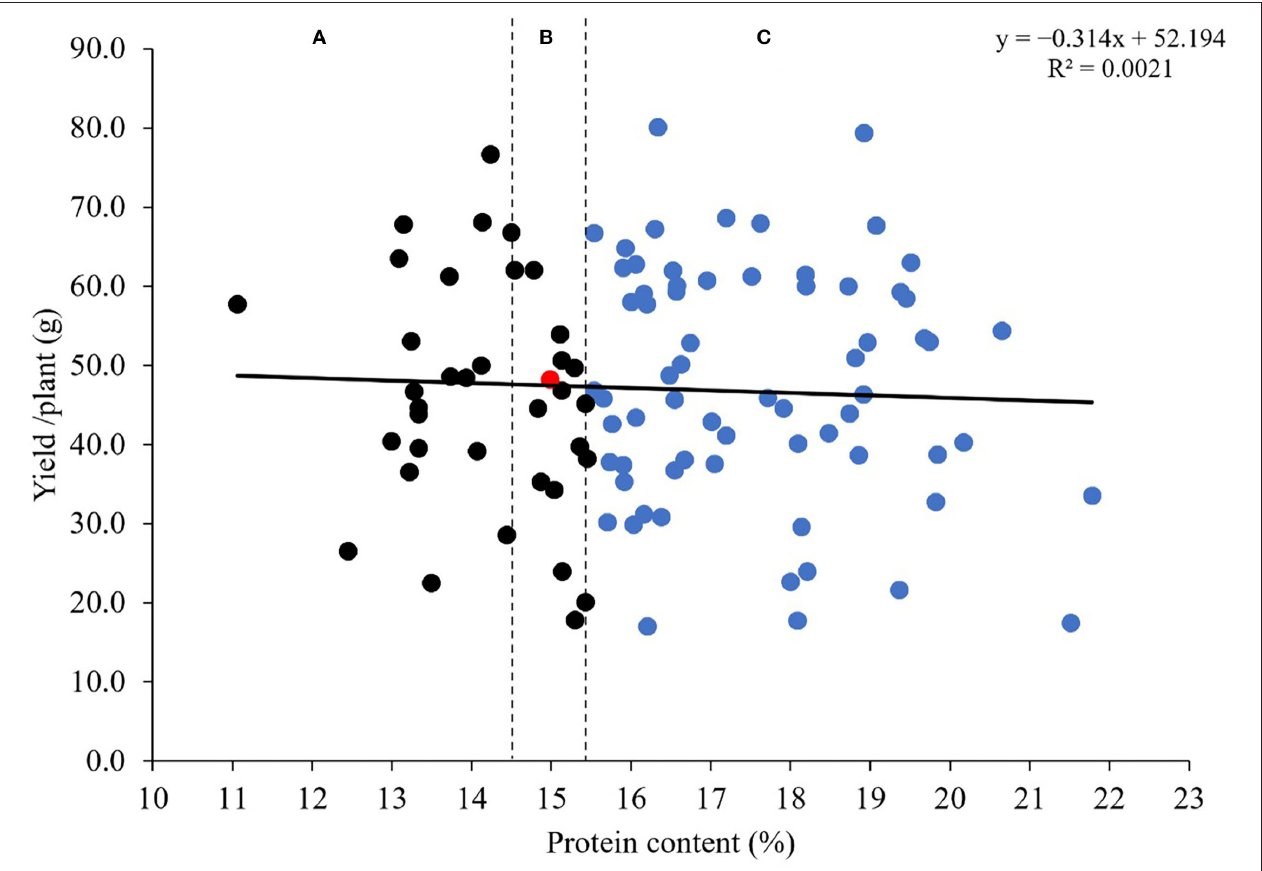
FIGURE 6 | Regression analysis of the relationship between protein content (%) and grain yield/plant (g) for 103 MSD lines that derived their HMW-GS from Ae. tauschii and the recurrent parent N61, shown by a red dot. Vertical dotted lines classify results of comparable grain yield/plant into those with (A) a lower protein content than N61, (B) a comparable protein content than N61, and (C) a higher protein content than N61 (indicated with blue